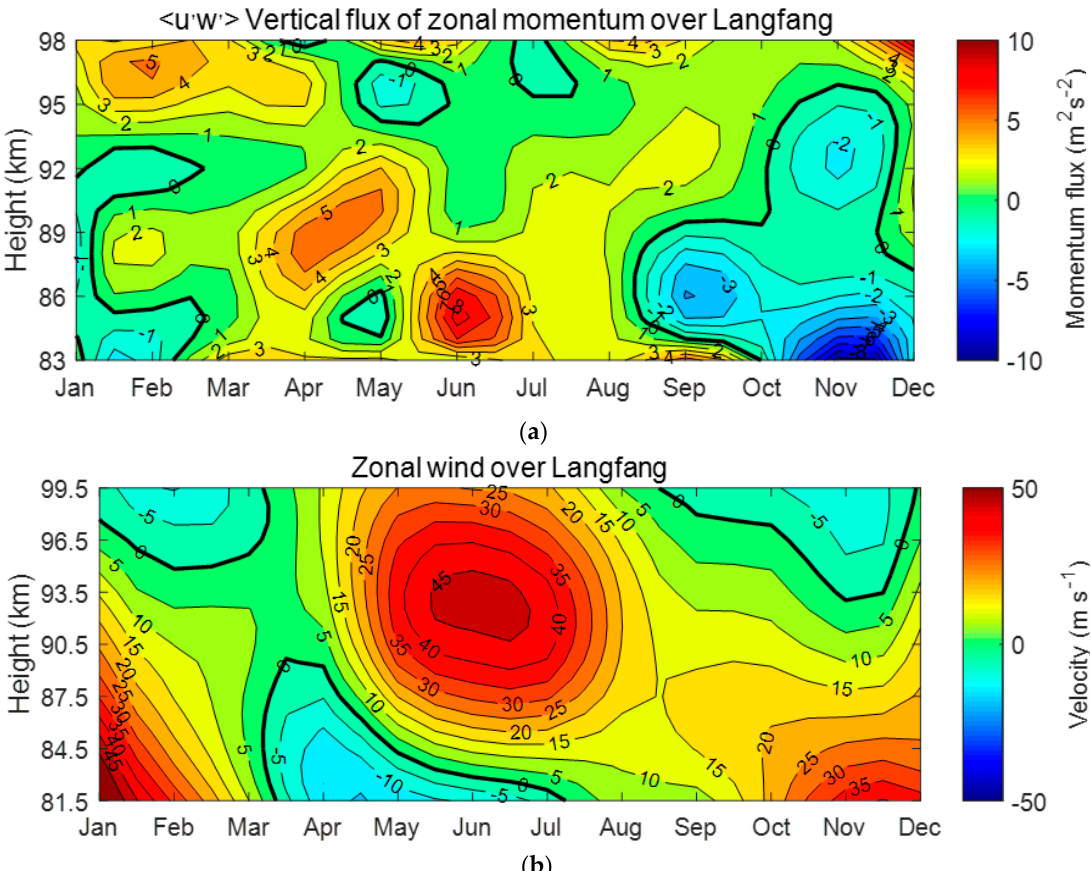
Figure 1. Height-time cross-sections of monthly averaged zonal momentum flux (upper panel) and zonal background wind (lower panel) over Langfang. Each line in the zonal momentum flux contour plot corresponds to 1 m 2 s − 2 and each contour in the zonal background wind corresponds to 5 m / s. ( a ) Vertical flux of zonal momentum over LangFang ( b ) Zonal wind over LangFang